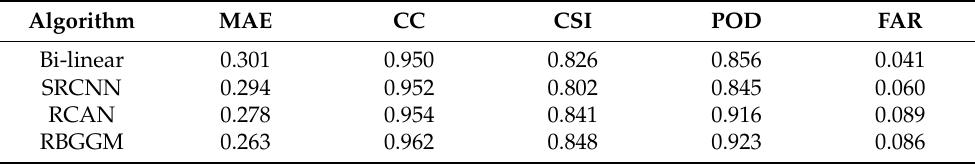
Table 3. Quantitative evaluation of different